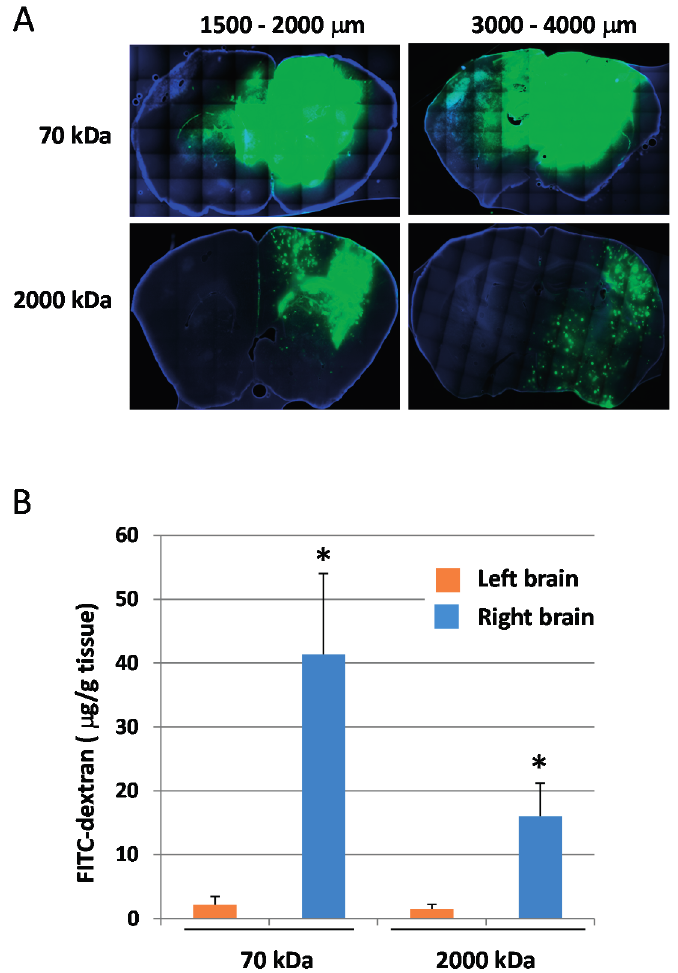
Figure 4. Delivery of fluorescent-labeled dextran into the brain by the combination of BLs and HIFU exposure. ( A ) Distribution of fluorescent-labeled dextran in coronal sections. Right brain: HIFU-exposed site. Left brain: control (nonexposed site). The mice were injected in the tail vein with Bubble liposomes (100 mg/mouse) and exposed to HIFU with 3.5 MHz, 10% Duty, 1.5 kw/cm 2 , 60 s. After 5 min, each mouse was injected with fluorescent-labeled dextrans (70 or 2000 kDa: 100 mg/mouse). After three hours, the brains were collected. The brain sections were sliced at 200 µm. The nuclei were stained with DAPI. Each specimen was observed by fluorescent microscopy. Each sectioned depth region from the frontal lobe of the cerebrum is shown above the corresponding photograph. ( B ) Quantification of fluorescent-labeled dextran. The treated brains were collected, and the fluorescent-labeled dextrans were extracted. Each value represents the mean S.D. ( n = 4). * p < 0.05 vs. left